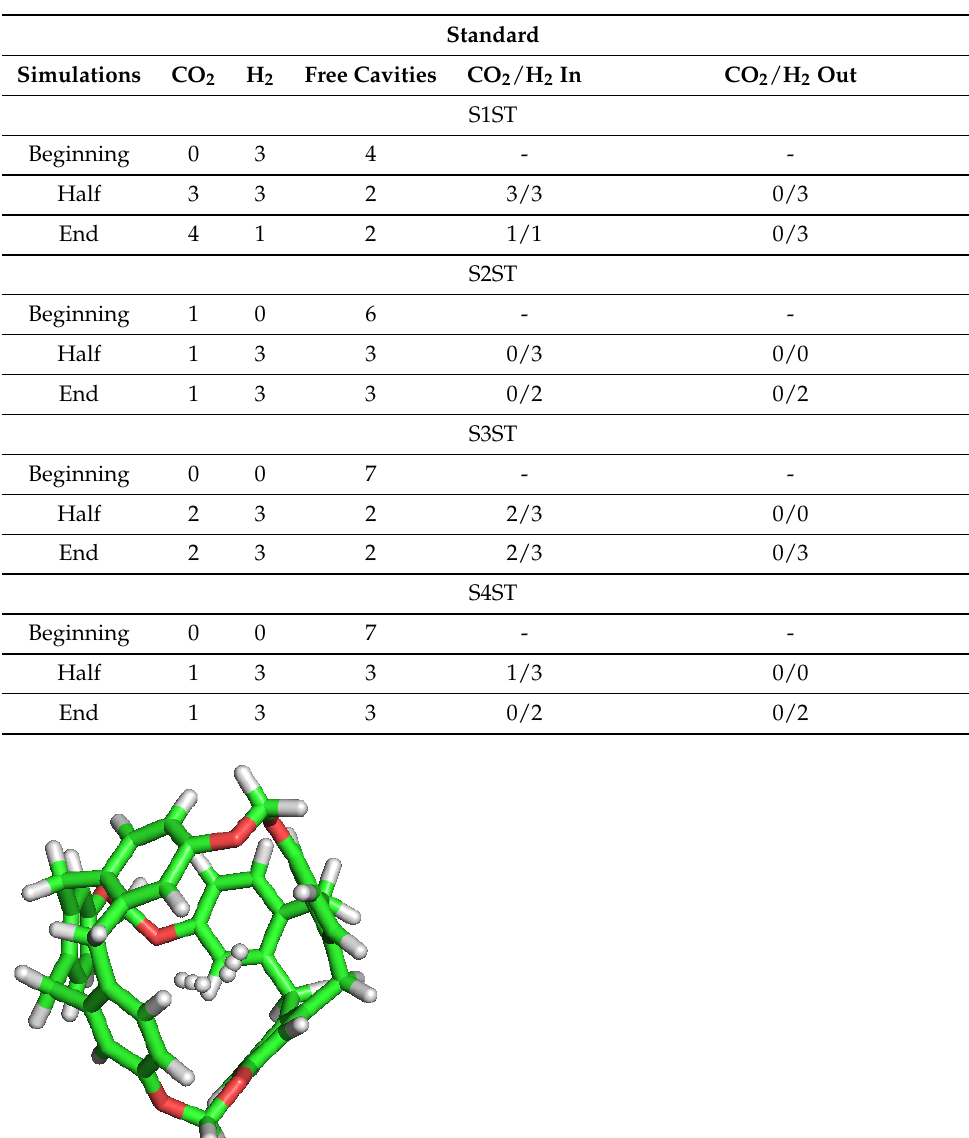
Table 1. Simulation results for the ST runs (300 K and 1 bar).